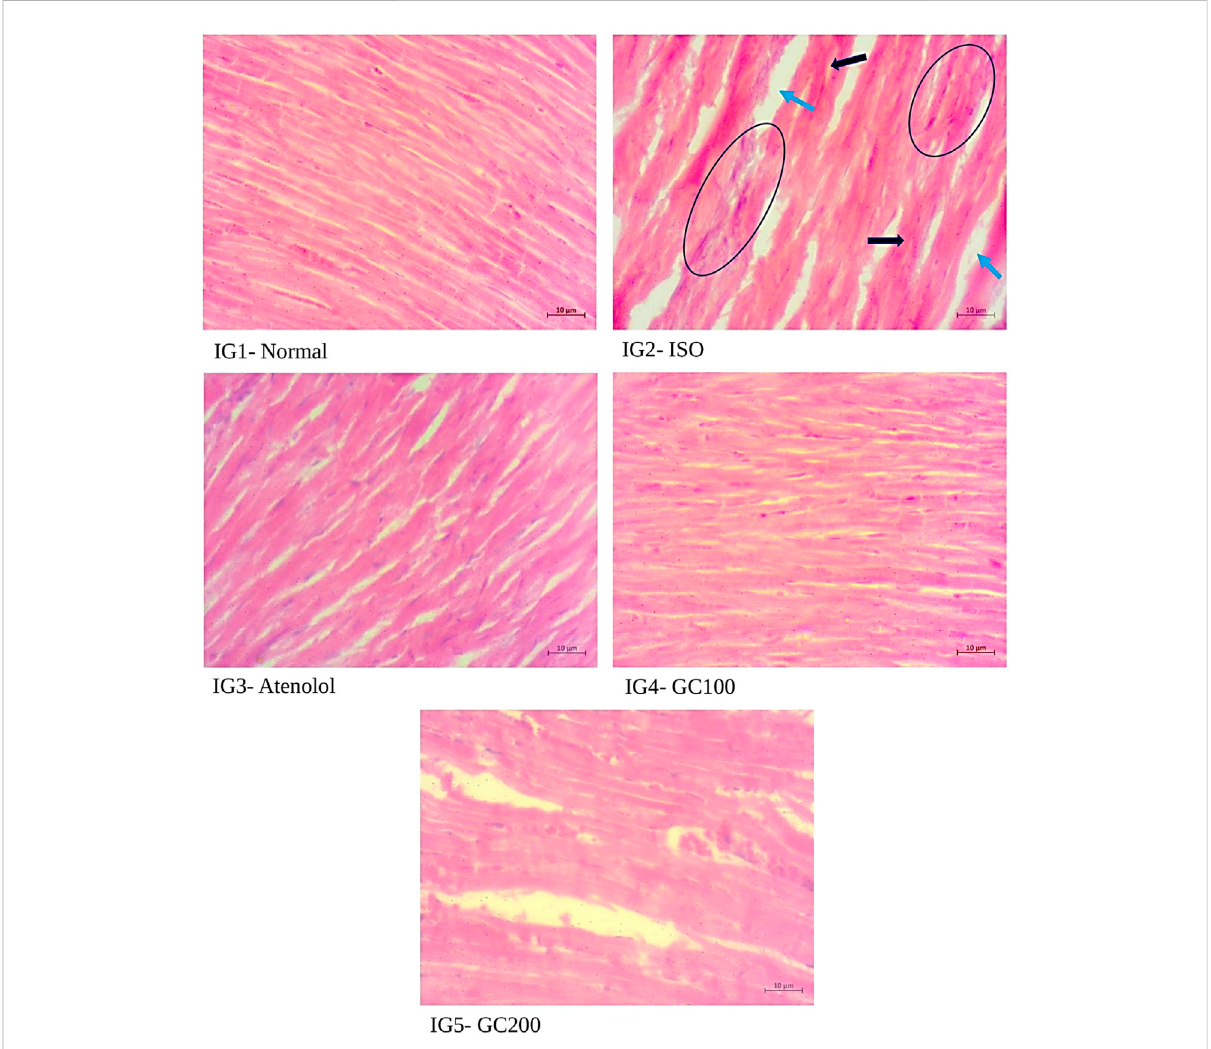
FIGURE 10 HistopathologicalanalysisofH&Estaining-acomparisonwiththenormal,ISOtreatedandGC-pre-treatmentexperimentalgroups.Scalebar- 10 μ m, Magni fi cation ×400. (Blue arrow- infracts, black arrow- wavy myo fi brils, circles — Necrotic